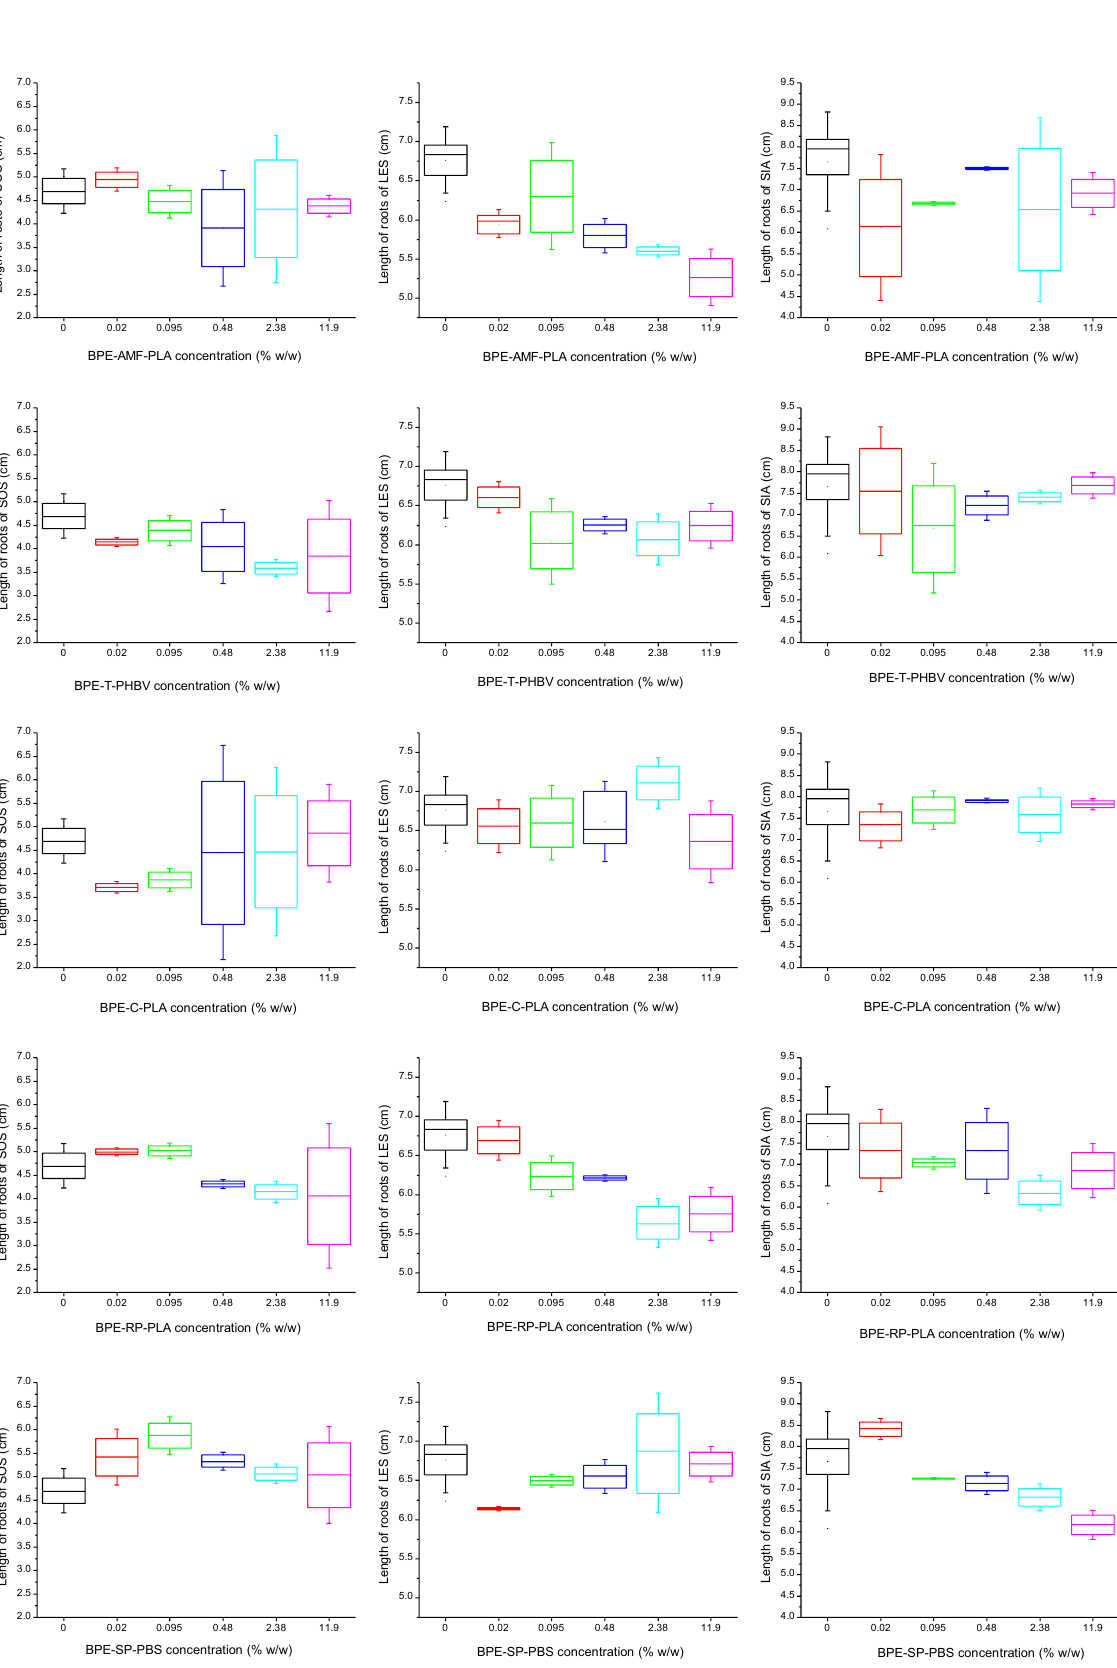
Figure 2. Effect of bio-based plastics on root growth of higher plants: Sorghum saccharatum (SOS), Lepidium sativum (LES) and Sinapsis alba (SIA).